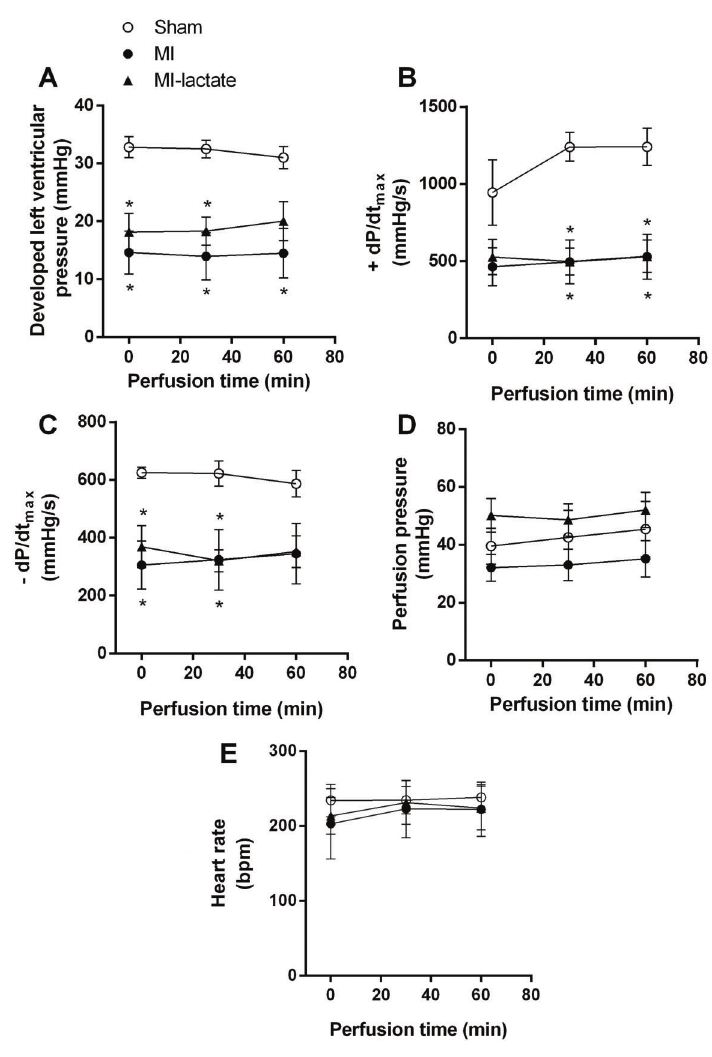
Figure 1. A , Left ventricular developed pressure, B , maximum positive ( + dP/dt max and C , nega- tive (-dP/dt max ), D , perfusion pressure, and E , heart rate after 60 min of perfusion with Krebs- Henseleit or KH plus lactate. MI: myocardial infarction. Data are reported as means ± SE of 6 hearts. *P o 0.05 compared to Sham group